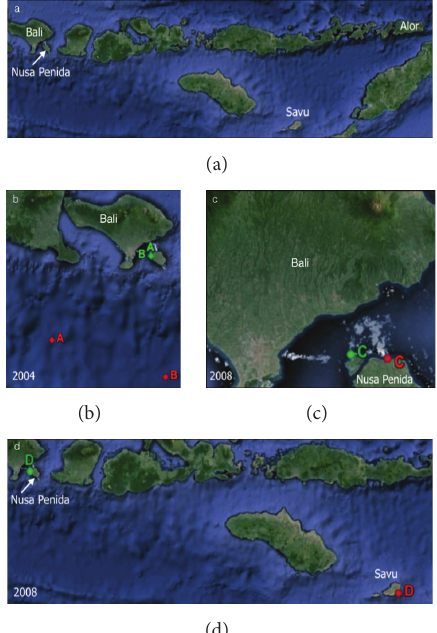
Figure 3: Fish deployment (green) and pop-off (red) locations. (a) Indonesian regions where fish traveled. (b) 2004 deployments and pop-offs for Fishes A and B. (c, d) Fishes C and D in 2008. Pop-off locations based on location codes ≥ 1. See Table 1 for fish IDs and deployment/pop-off dates.